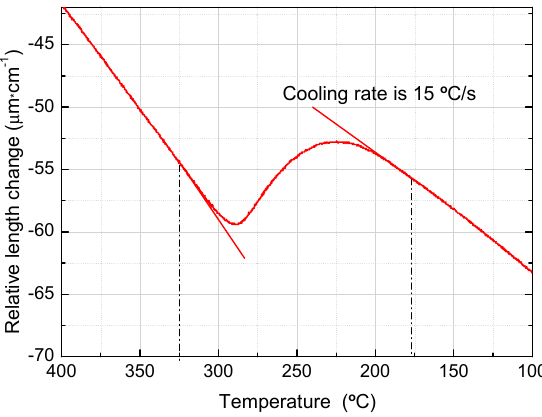
Figure 3. Relative length changes of dilatometric specimen during martensitic transformation.